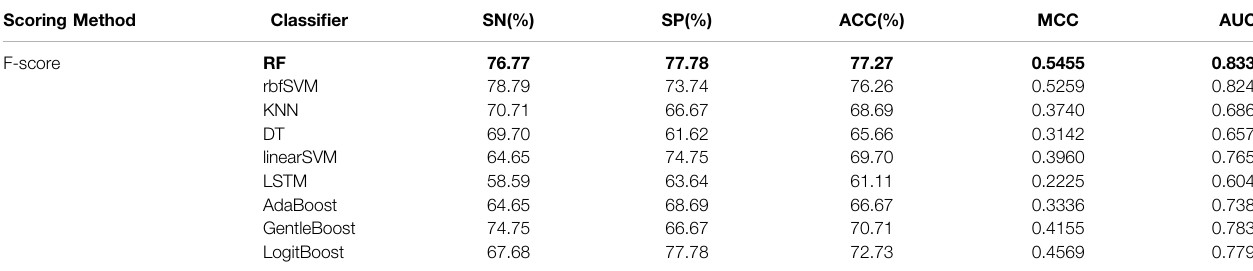
TABLE 3 | The prediction performances of different classi fi ers in the independent testing dataset. Scoring Method